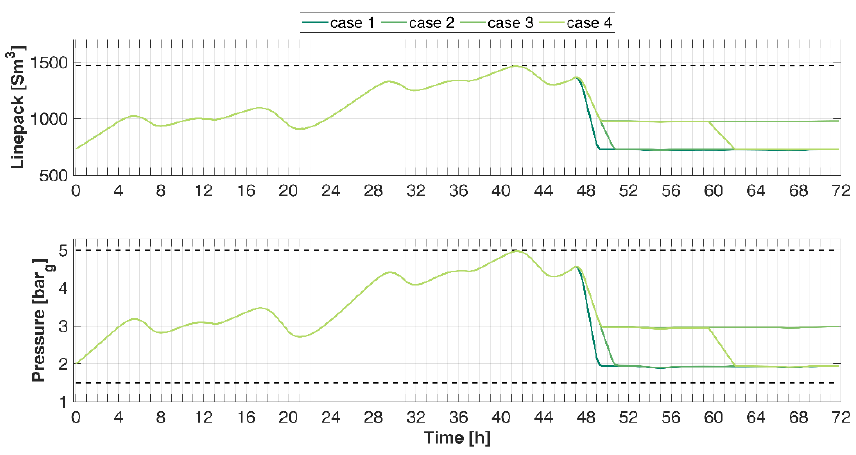
Figure 10. Linepack (above) and pressure (below) evolution over a three-day simulation in which different strategies for the transition to normal operating conditions are compared. For the first 48 h, the network is operated at a pressure set point at the city gate of 2 bar g and the injection is reduced to 35.5%. Then: case (1) “nothing changes”: the pressure set point at the city gate is maintained at 2 bar g and the injection is kept reduced. Case (2) restoring the injection: the pressure set point at the city gate is maintained at 2 bar g and the injection is turned to 100%. Case (3) the pressure set point at the city gate is changed to 3 bar g and the injection is turned to 100%. Case (4) “modulating pressure”: the pressure set point at the city gate is changed to 3 bar g and after 12 h is linearly decreased to 2 bar g again while the injection is turned to 100% since the beginning of the third day.